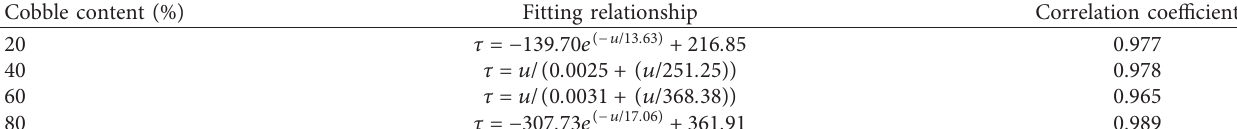
Table 2: Fitting relationship between shear stress and shear displacement of sand and cobble soil with different CCs. Cobble content (%)